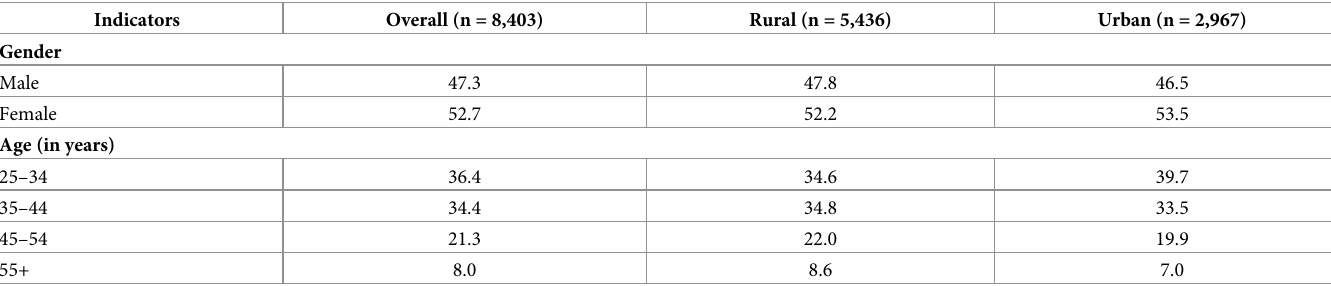
Table 1. Demographic and geographic characteristics of the